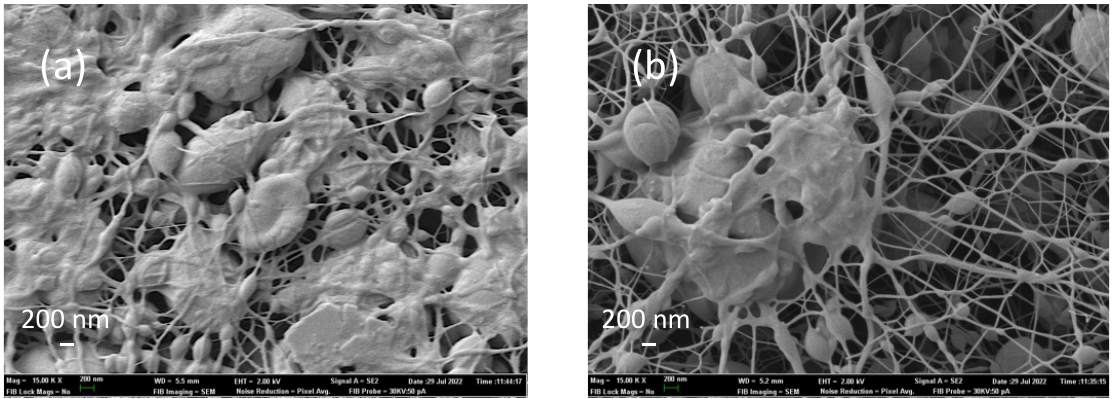
Figure 10. Surface of the nanofiber veils with beads after the pressure test. ( a ) Sage; ( b ) thyme.